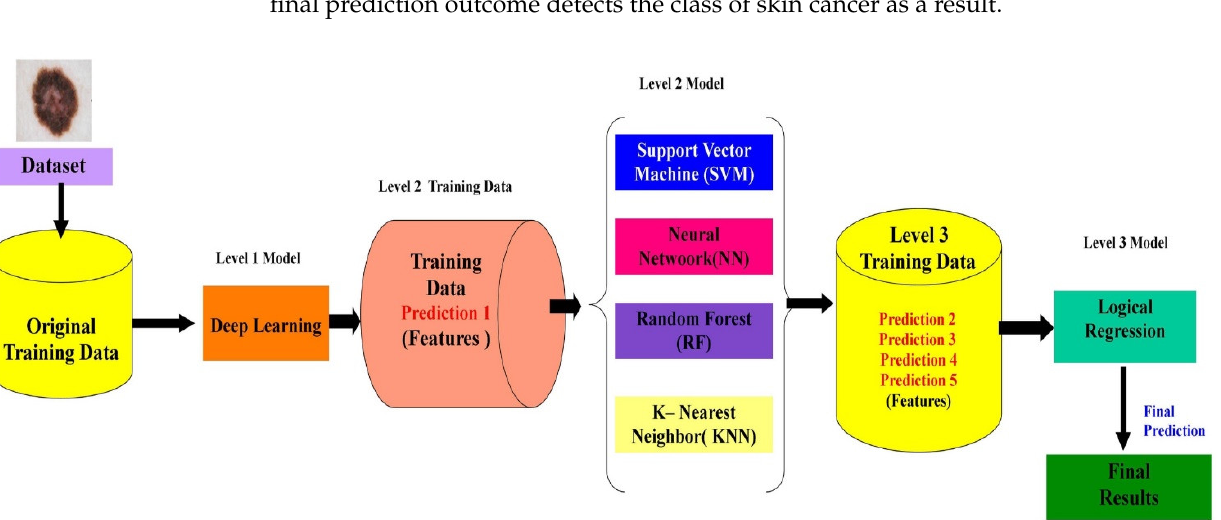
Figure 7. The basic architecture of stacked CV algorithm [35].